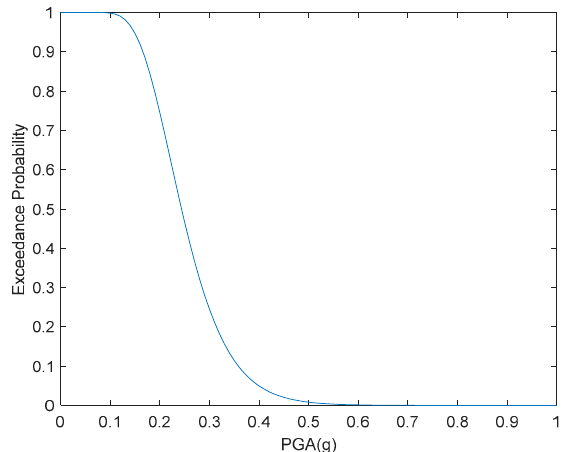
Figure 12. Exceedance probability distribution of the bridge considered having a 50 year of lifespan.